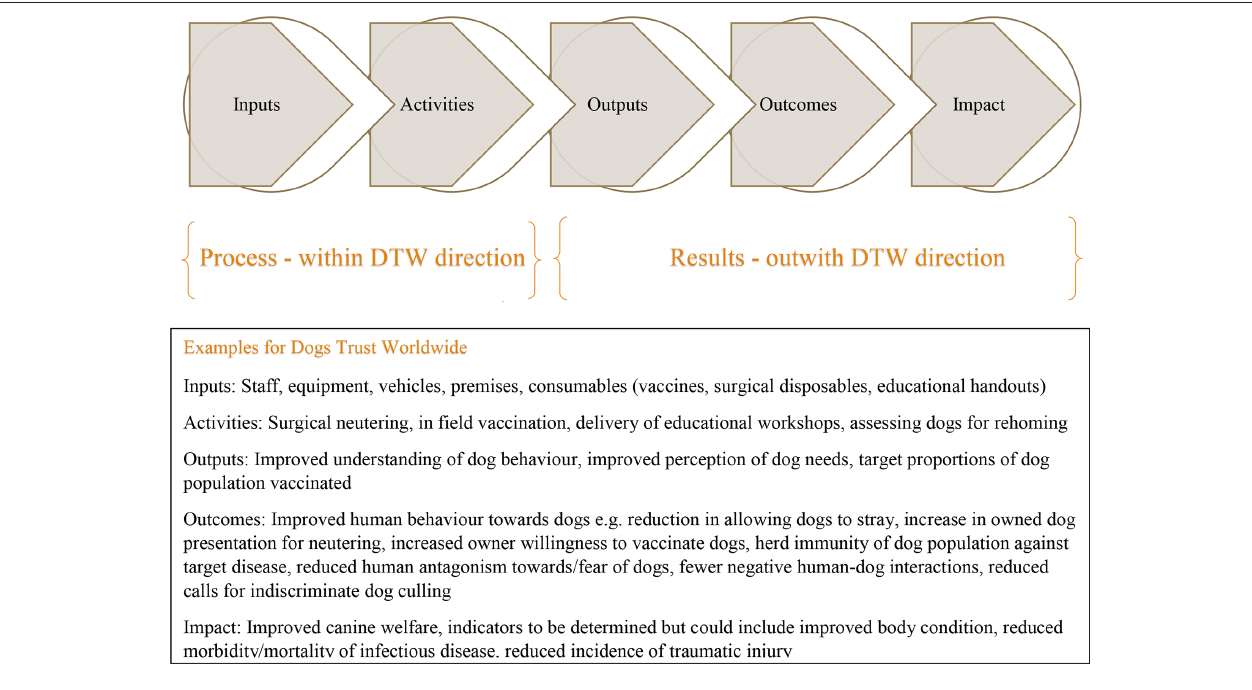
figure 1 | Results Based Management Framework as it relates to Dogs Trust